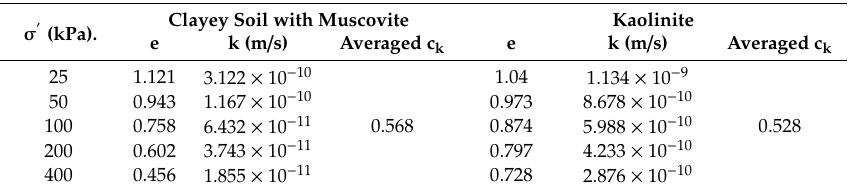
Table 13. Constitutive permeability parameters c k and k o for the two soils. Data obtained from tests with hydraulic